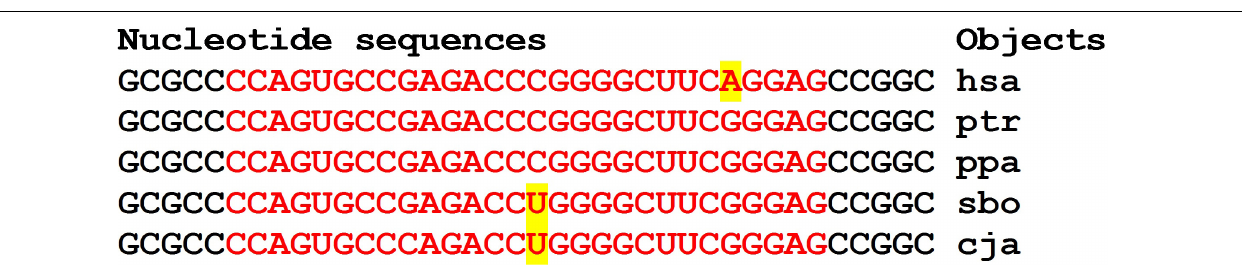
FIGURE 7 | Nucleotide sequences of 5 (cid:48) UTR regions of mRNAs of orthologous LRP10 genes containing clusters of miRNAs binding